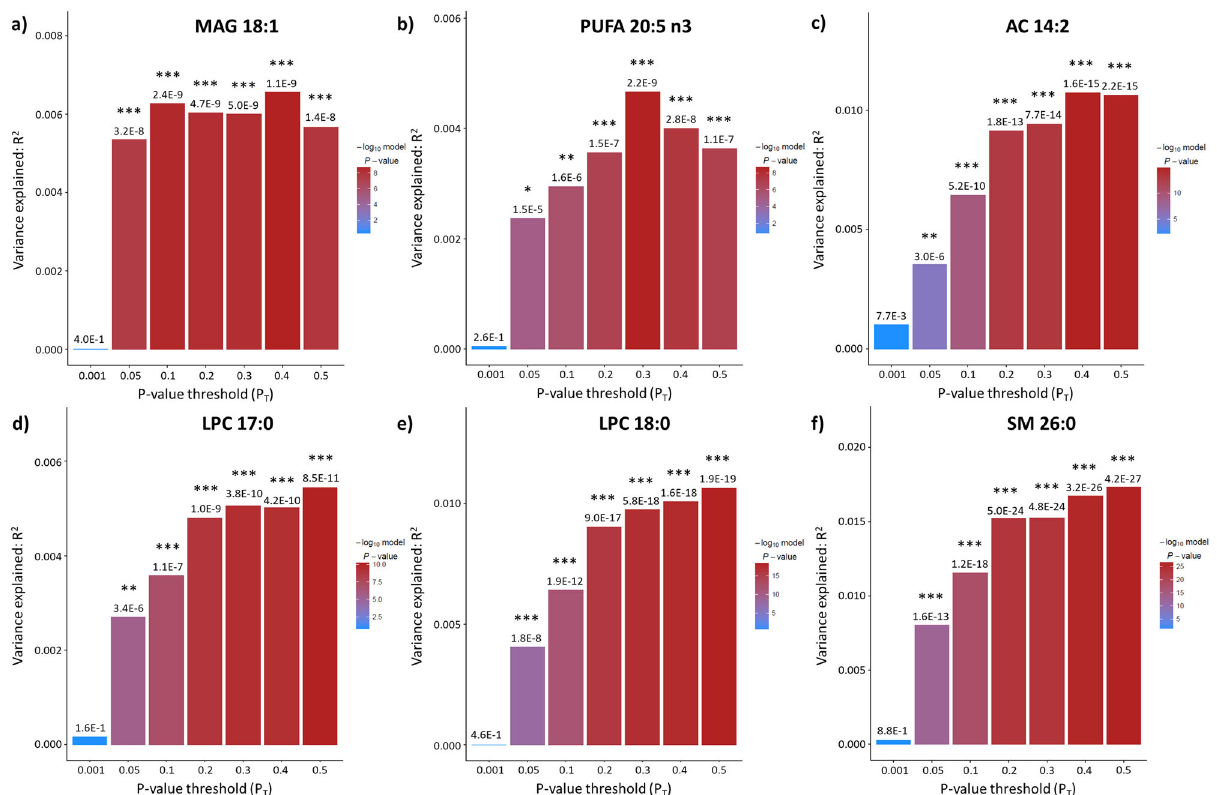
Fig. 1 Shared genetic etiology between Parkinson ’ s disease (PD) and blood levels of MUFA 18:1, PUFA 20:5n3, AC 14:2, LPC 17:0, LPC 18:0, and SM 26:0. Bar plots for shared genetic etiology between PD and the blood levels of monounsaturated fatty acid 18:1 ( a ), polyunsaturated fatty acid 20:5n3 ( b ), acylcarnitine (AC) 14:2 ( c ), lysophosphatidylcholine (LPC) 17:0 ( d ), lysophosphatidylcholine (LPC) 18:0 ( e ), and sphingomyelin (SM) 26:0 ( f ) showing the variance explained ( R 2 ) and the SNP P value threshold ( P T ). The asterisks above the bars indicate the Bonferroni-corrected signi fi cance of the genetic overlap between PD and the blood lipid levels; * denotes P < 0.05/2590 tests (7 thresholds × 370 blood lipid levels) = 1.93E-05, ** denotes P < 0.01/2590 = 3.86E-06; *** denotes P < 0.001/2590 =